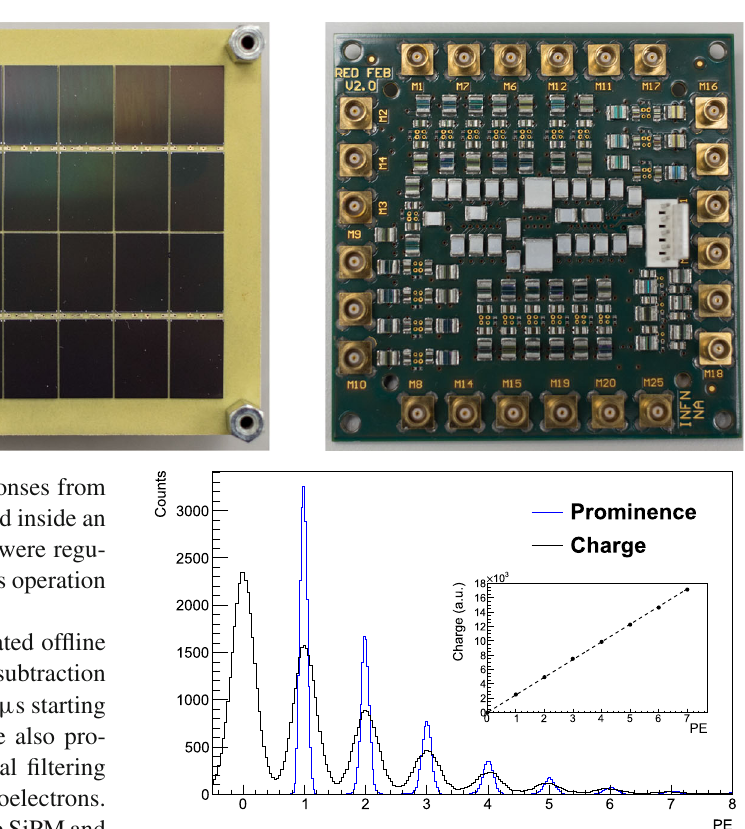
Fig. 5 Charge and prominence distributions, in number of photoelec- trons (PE), obtained from a typical laser calibration run for a top SiPM. The inset shows the linear fit used for the calibration between charge andnumberofphotoelectronsandfortheextractionoftheSinglephoto- Electron Response (SER). A similar linear calibration is also performed for the prominence